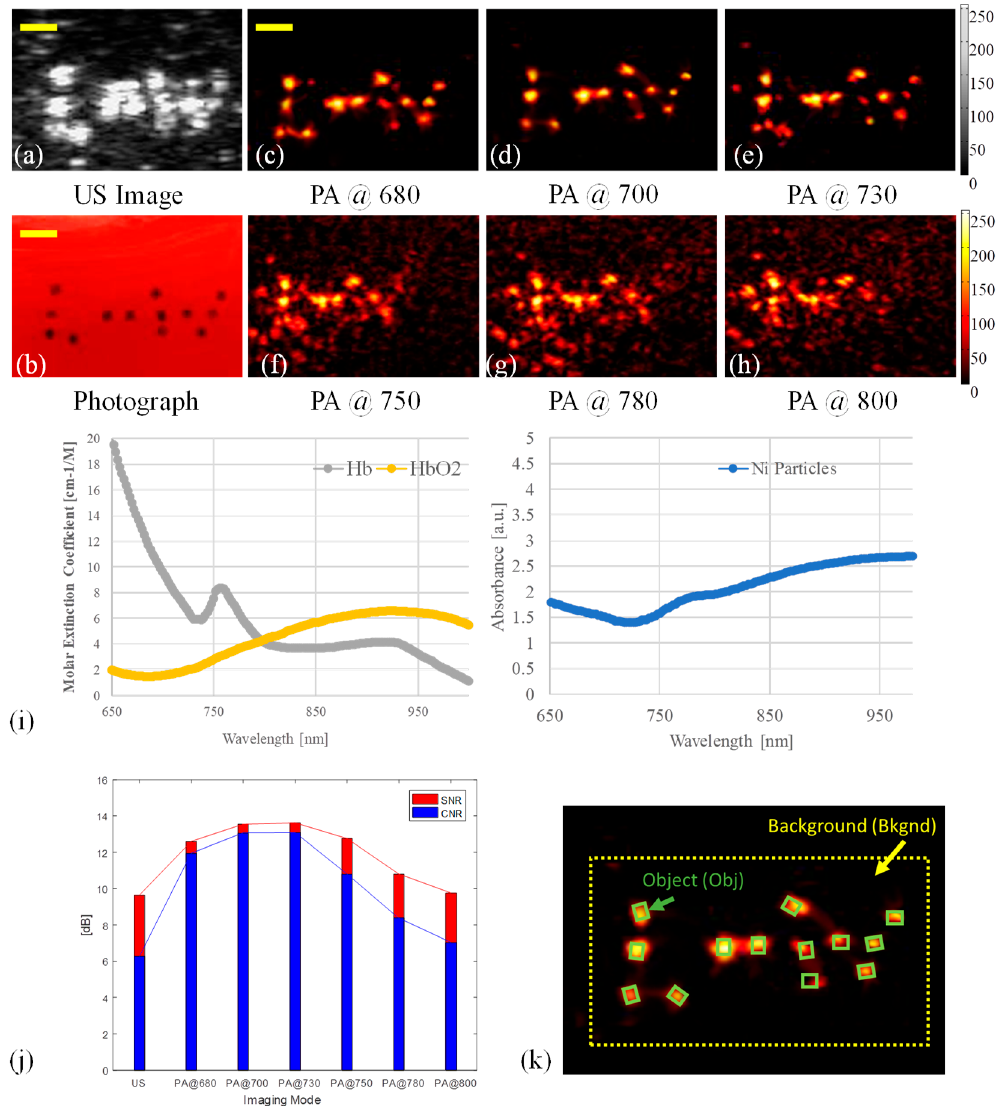
Figure 6. Imaging results for detecting microrobots in human blood. ( a ) US image of the “L··W” pattern. ( b ) Photograph of the pattern before covering with human blood. ( c-h ) PA images at different wavelengths between 680 and 800 nm. ( i ) Human oxy- and deoxy- hemoglobin molar extinction coefficients, and the Ni particle absorbance; the data were adopted from [31] and [32]. ( j ) Calculated SNR and CNR for US and PA images, the ROIs of the objects were selected based on the optical image. ( k ) A sample PA image (acquired at 700 nm) of the selection for ROIs, where the green rectangles indicate the PA signal from microrobot objects, and the yellow rectangle indicates the area of the background. The scale bars are 1 mm.